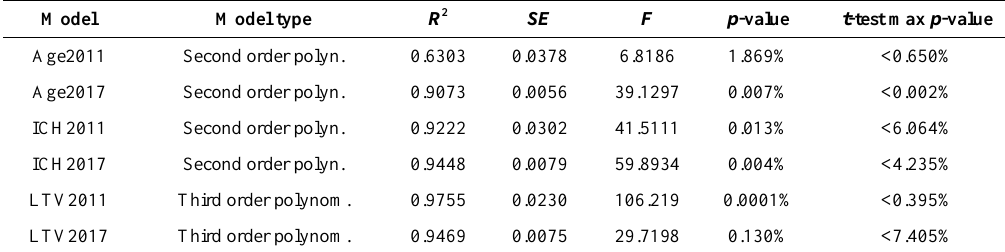
Table 5. Best fit model’s regression